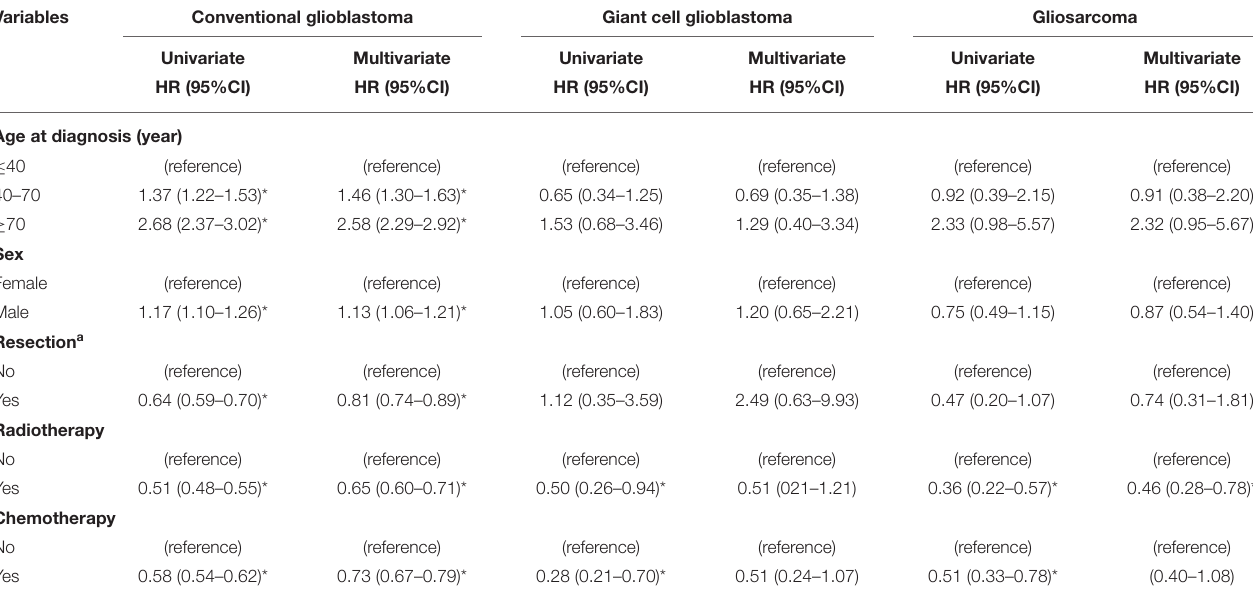
TABLE 3 | Univariate and multivariate stratified Cox regression analyses of survival of conventional glioblastoms and histologic variants.